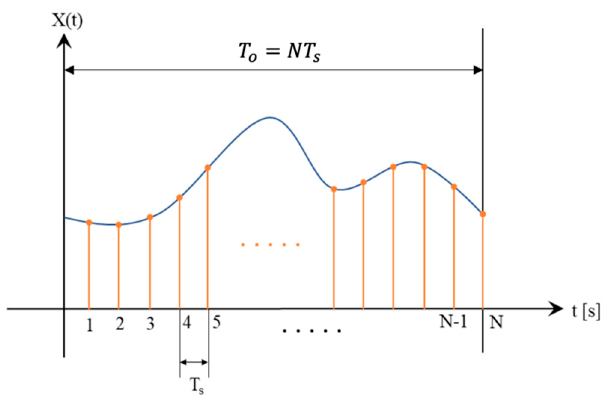
Figure 3. Sampling principle of an arbitrary